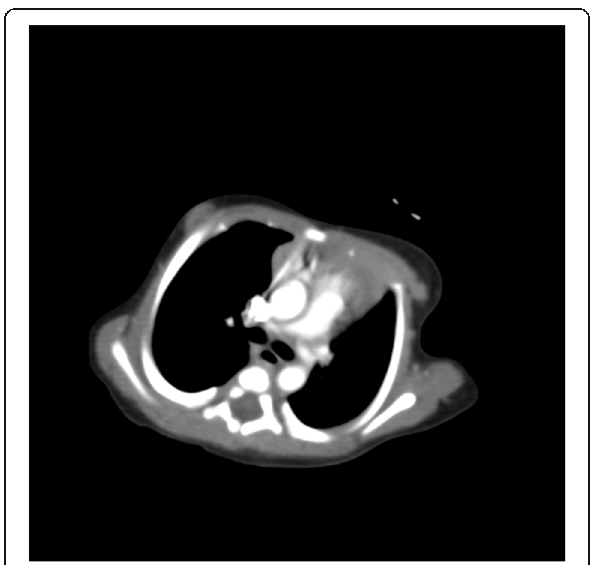
Fig. 2 CT pulmonary angiography showing eccentric filling defect at the origin of left pulmonary